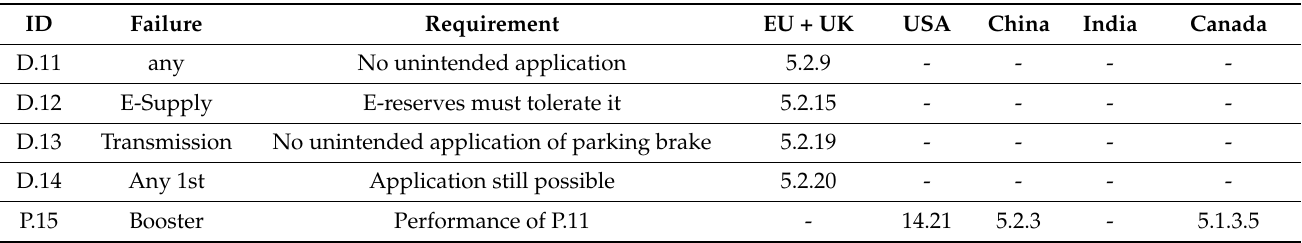
Table 4. Sections of the standard documents related to the design requirements concerning failure tolerance of EMB service braking